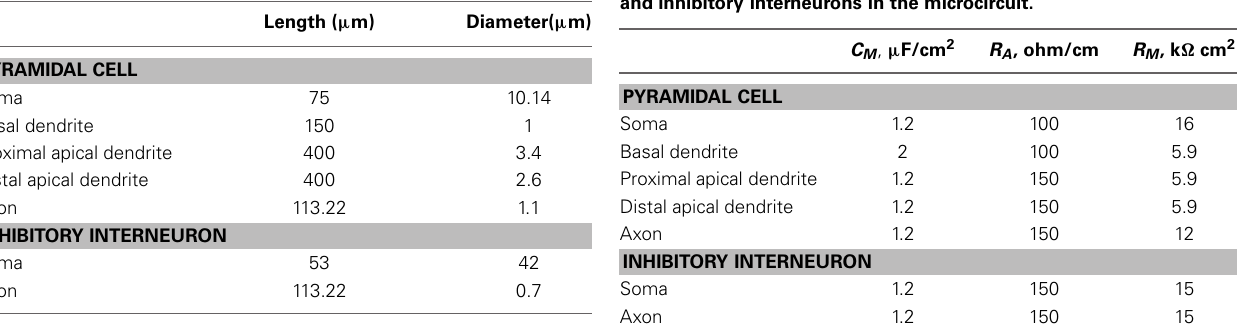
FIGURE 1 | Validation of intrinsic and synaptic properties of pyramidal and interneuron models. (A). Validation of the delayed afterdepolarization (dADP). Top traces: experimental recording of a layer V PFC pyramidal neuron following 5 or 2 actions potentials in response to current clamp stimulation at 20Hz (reprinted with permission from Sidiropoulou et al., 2009). Bottom traces: simulated dADP in a single pyramidal model neuron following 5 or 2 actions potentials in response to current clamp stimulation at 20Hz and activation of the dADP mechanism. The action potentials are truncated for better visualization of the dADP. (B) Voltage response of the pyramidal neuron model to a 0.25nA , 500ms step pulse. (C) Validation of the kinetics and iNMDA-to-iAMPA ratio at the basal dendrites of pyramidal neuron models. Left: experimental trace (reprinted with permission from Wang et al., 2008), showing the response in the soma of a layer V prefrontal pyramidal neuron after stimulation of a pyramidal–pyramidal pair under voltage clamp conditions at − 70mV (iAMPA) and at + 60mV under blockage of AMPA receptors (iNMDA). Copyright (2008) National Academy of Sciences, U.S.A. Right, black traces: model reproduction of iAMPA ( − 70mV) and iNMDA ( + 60mV) under the same protocol, using the number Table 1 | Structure of model cells. Table 2 | Passive properties of all compartments of pyramidal cells